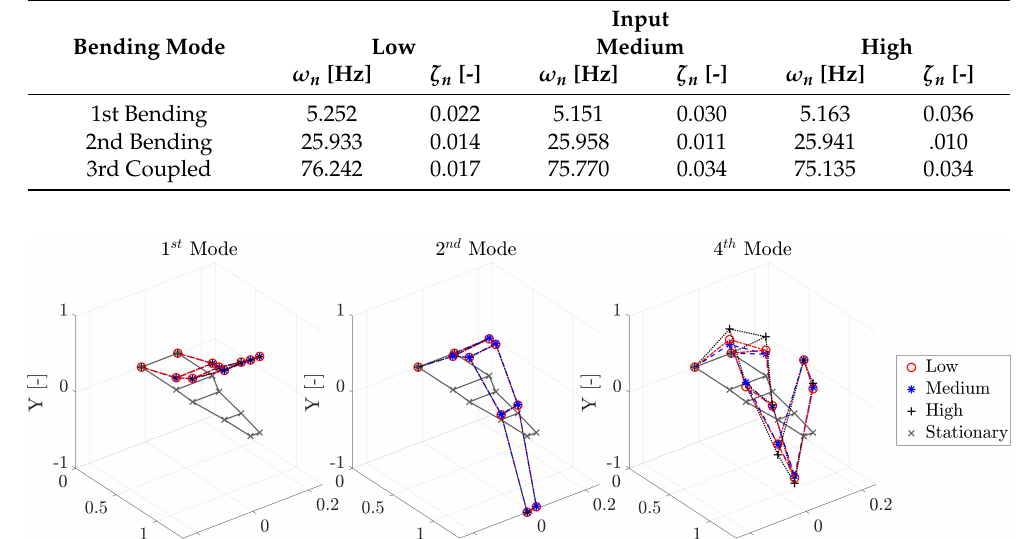
Figure 17. Spar and tube: Stabilisation diagrams the low-input scenario computed with the fol- lowing parameters: ∆ f = 1%, ∆ ζ = 5% and MAC = 0.95. The FRF of channels # 3L and 4L are superimposed for further mode visualisation. Table 10. Spar and tube: Natural frequency and damping ratio parameters.